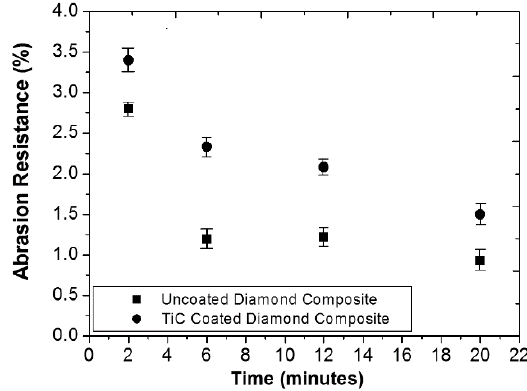
Figure 19. Abrasion Resistance (AR %) of Fe-diamond composites as a function of time. Mean values for three samples of each